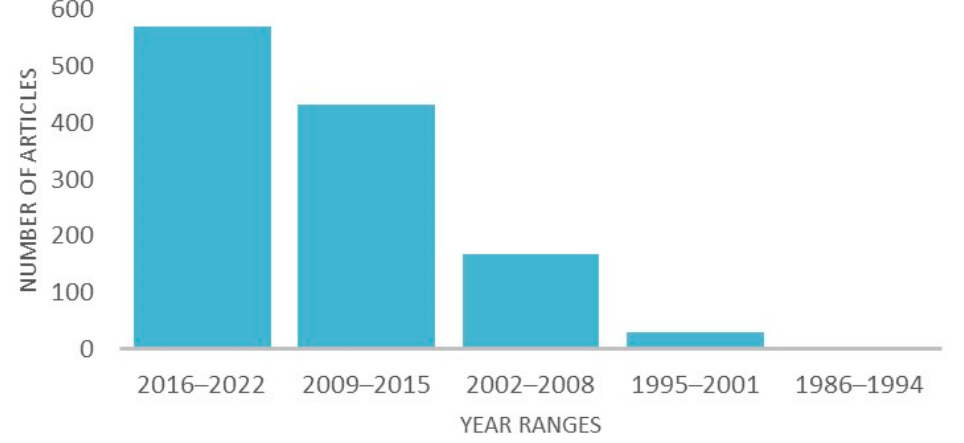
Figure 2. Number of articles found in the systematic search in Web of Science grouped by period of time.